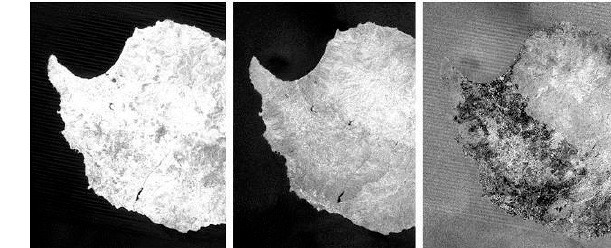
Figure 6. NDVI in Paphos District: in 1987 (left), in 2016 (middle). The difference between 1987 and 2016 (right).